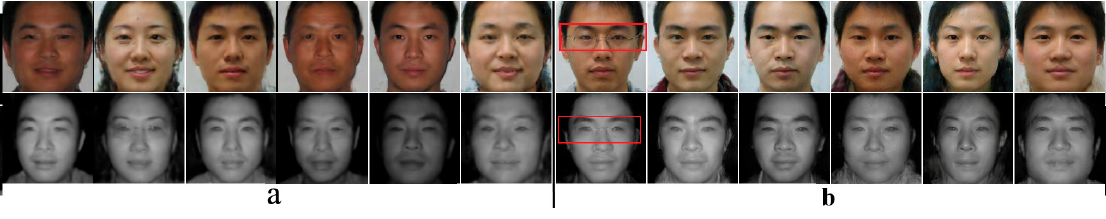
Figure 7. Generated images of DVG ( a ) and SADG ( b ).